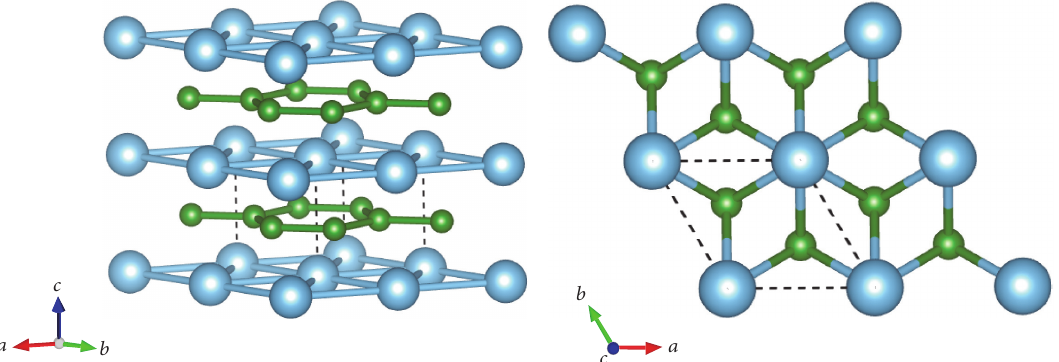
Figure 2: The 2 × 2 × 2 supercell of TiB 2 . Blue and green balls denote Ti and B atoms, respectively. Dashed box represents the unit cell of TiB 2